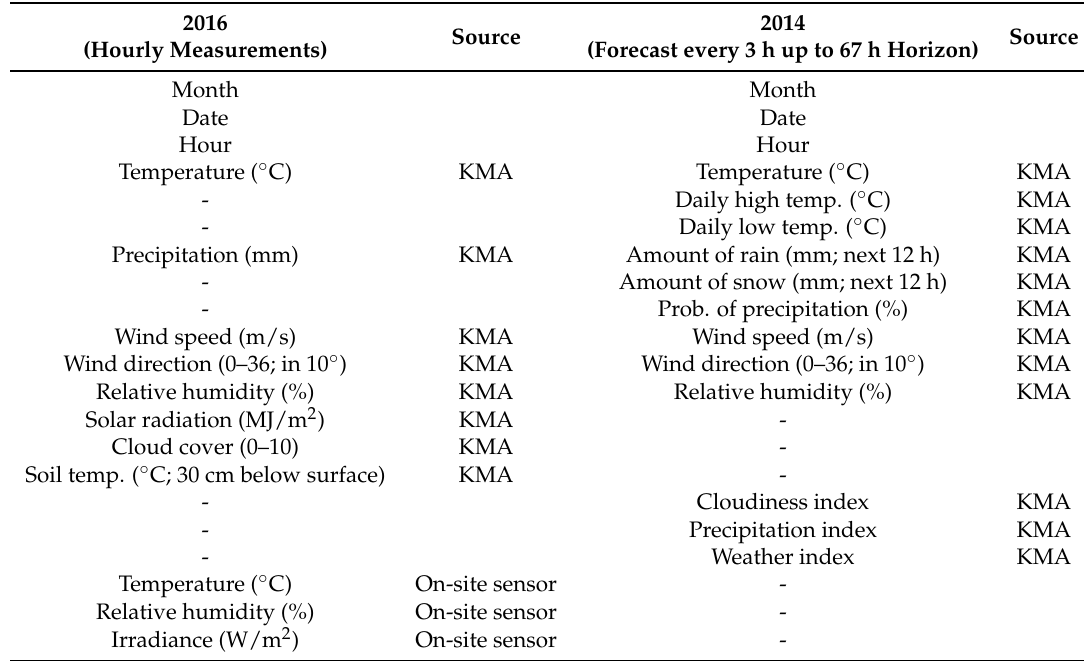
Table 1. Historical data sets with their features as potential input parameters to our forecast model (KMA: Korean Meteorological